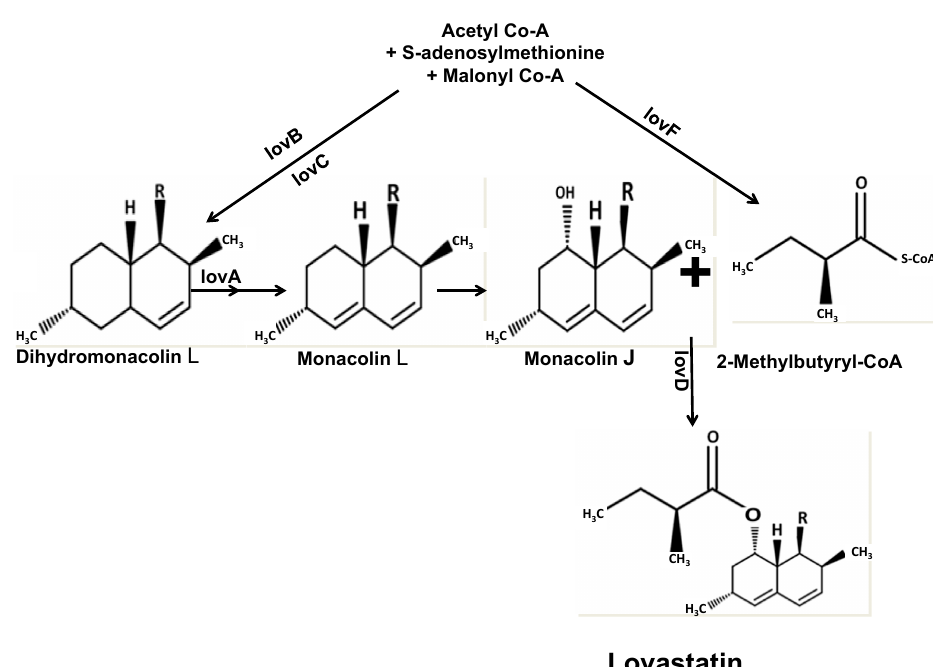
Figure 2. Pathway leading to lovastatin biosynthesis.